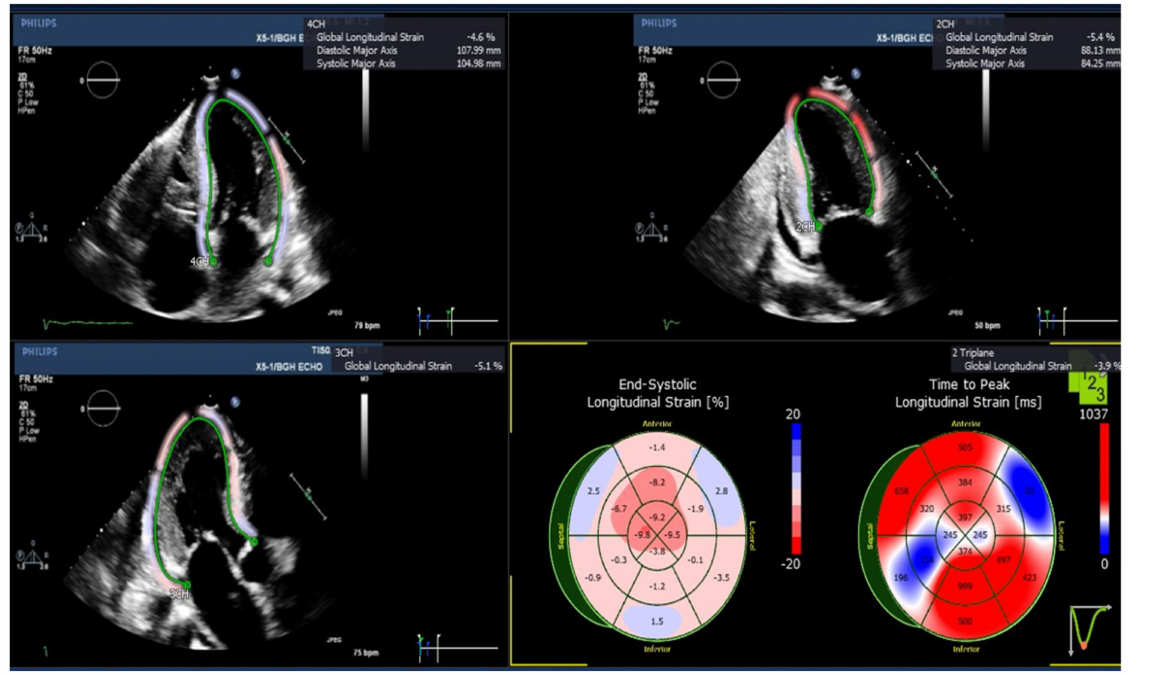
Figure 2. Left ventricular (LV) longitudinal strain imaging of cardiac amyloidosis using speckle tracking echocardiography. The basal segments are noted to exhibit dyskinetic motion, as observed by the outward movement of the basal inferior, basal anteroseptal and basal anterolateral segments. The apical segments are more contractile, but still relatively